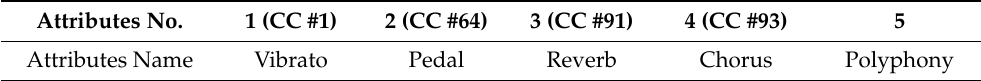
Table 2. The number and name of all Control Change (CC) messages used by pre-experiments. Attributes